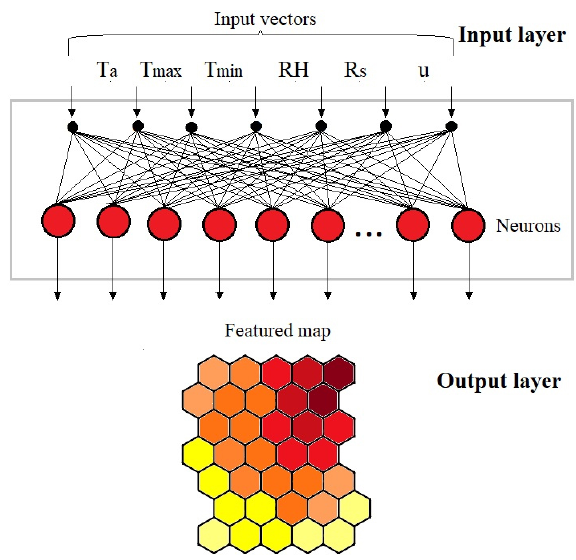
Figure 3. Illustration of the winning node and its neighbourhood in the Kohonen self-organising map